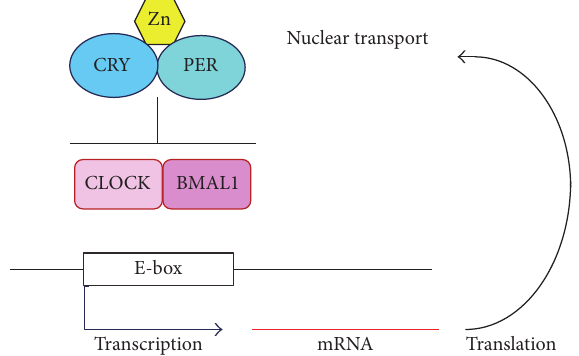
Figure 2: Molecular transcriptional/translational feedback loop (TTFL) model for mammalian circadian